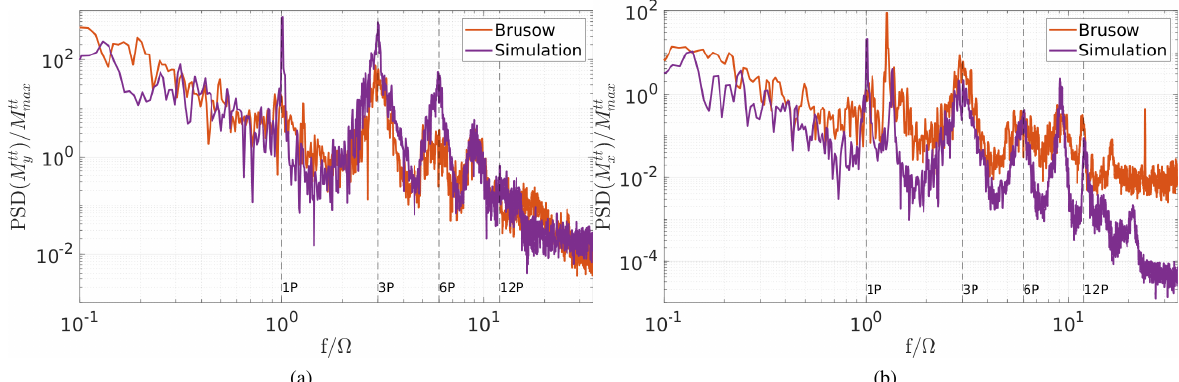
Figure 16. Spectrum of the tower top bending moment in (a) the fore-to-aft direction M tt y and (b) the side-to-side direction M tt x ; comparison of the measurement data to the simulation results (stable). The data are normalised by the maximum value of the tower top bending moments, and the frequency is normalised by the rotor